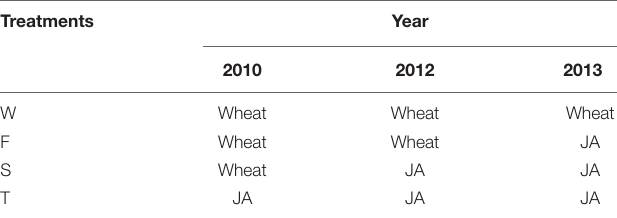
TABLE 1 | Experiment setup of the field experiment.